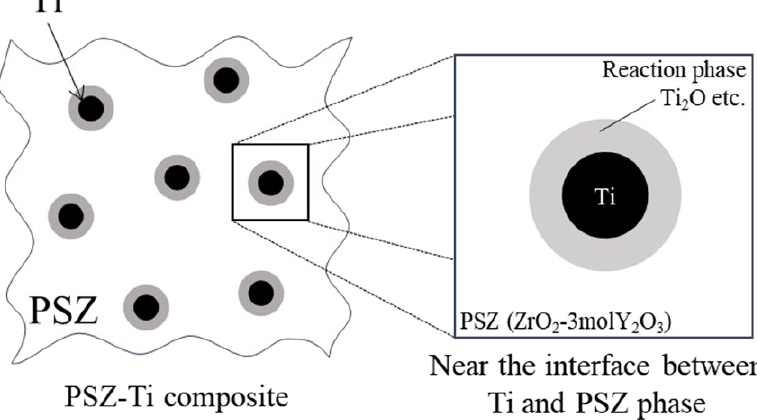
Figure 3. Schematic of PSZ-Ti composite fabricated via powder metallurgy technique [14,15].